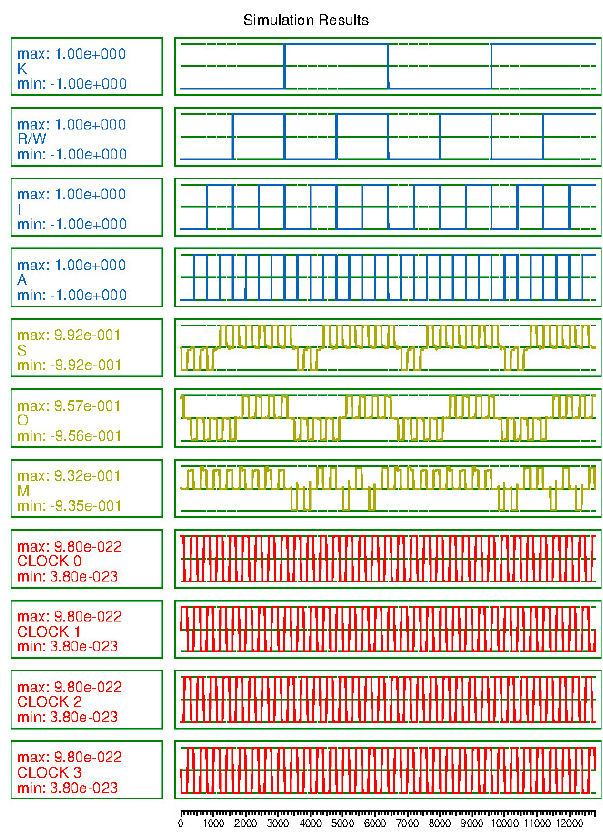
Figure 15. Simulation result of proposed CAM cell.